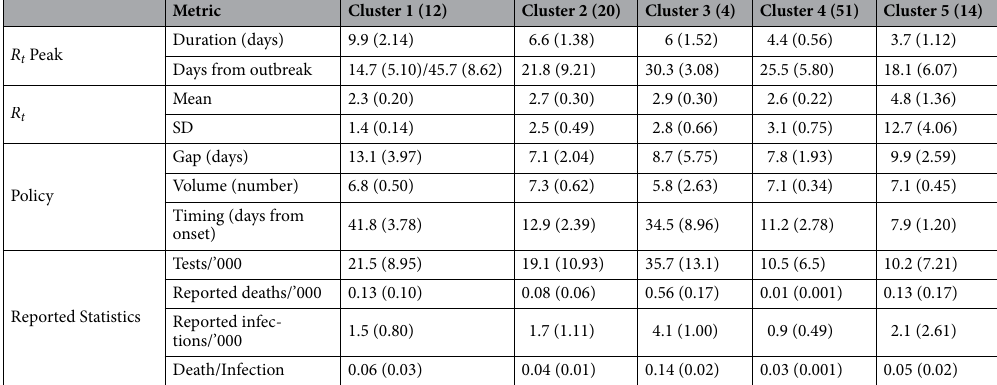
Table 1. Key descriptive statistics across clusters as at 15 May 2020. This table displays selected descriptive statistics from 101 selected countries at the beginning of the pandemic up to 15 May 2020. The first section (as indicated by the solid horizontal lines) records the pattern of estimated daily reproduction number. Only cluster 1 is characterized by countries having two peaks of similar levels in their daily reproduction numbers. The second section summarizes the pattern of 8 social distancing policies. The last section records the average number of observed tests, reported deaths, reported infections per thousand population and reported deaths per infection. We averaged these values across countries in each cluster and recorded their sample standard error times the 95% confidence level value in brackets. For a detailed description of each examined policy the reader is referred to the supplementary materia